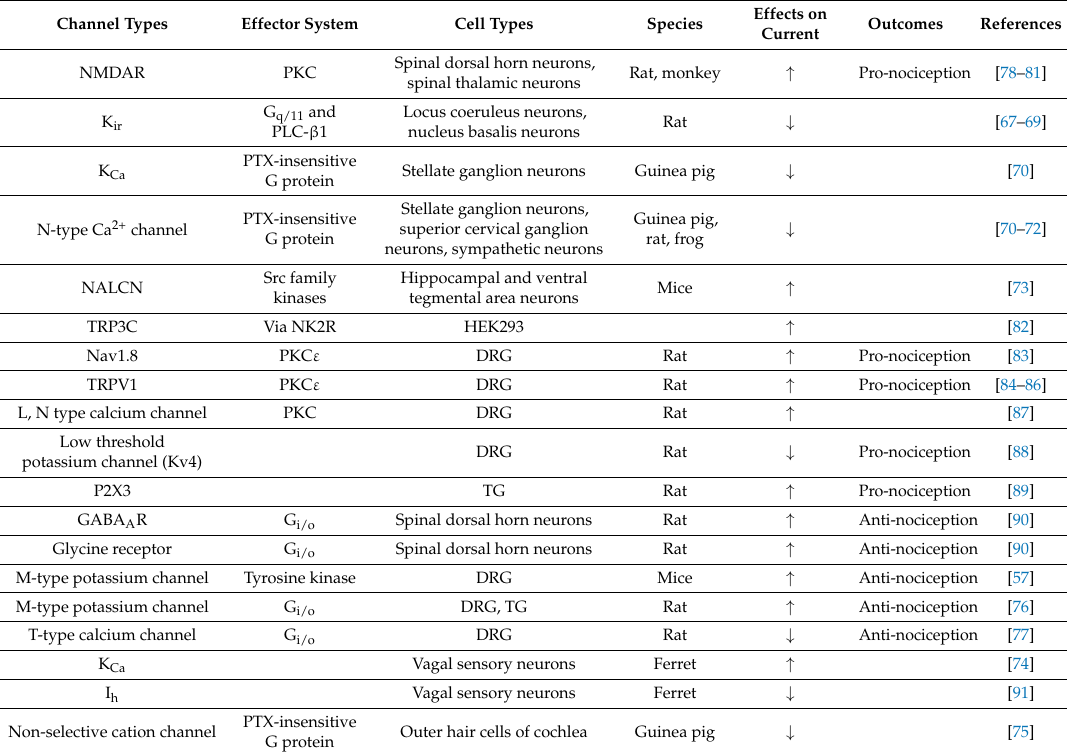
Table 1. Ion channels modulated by substance